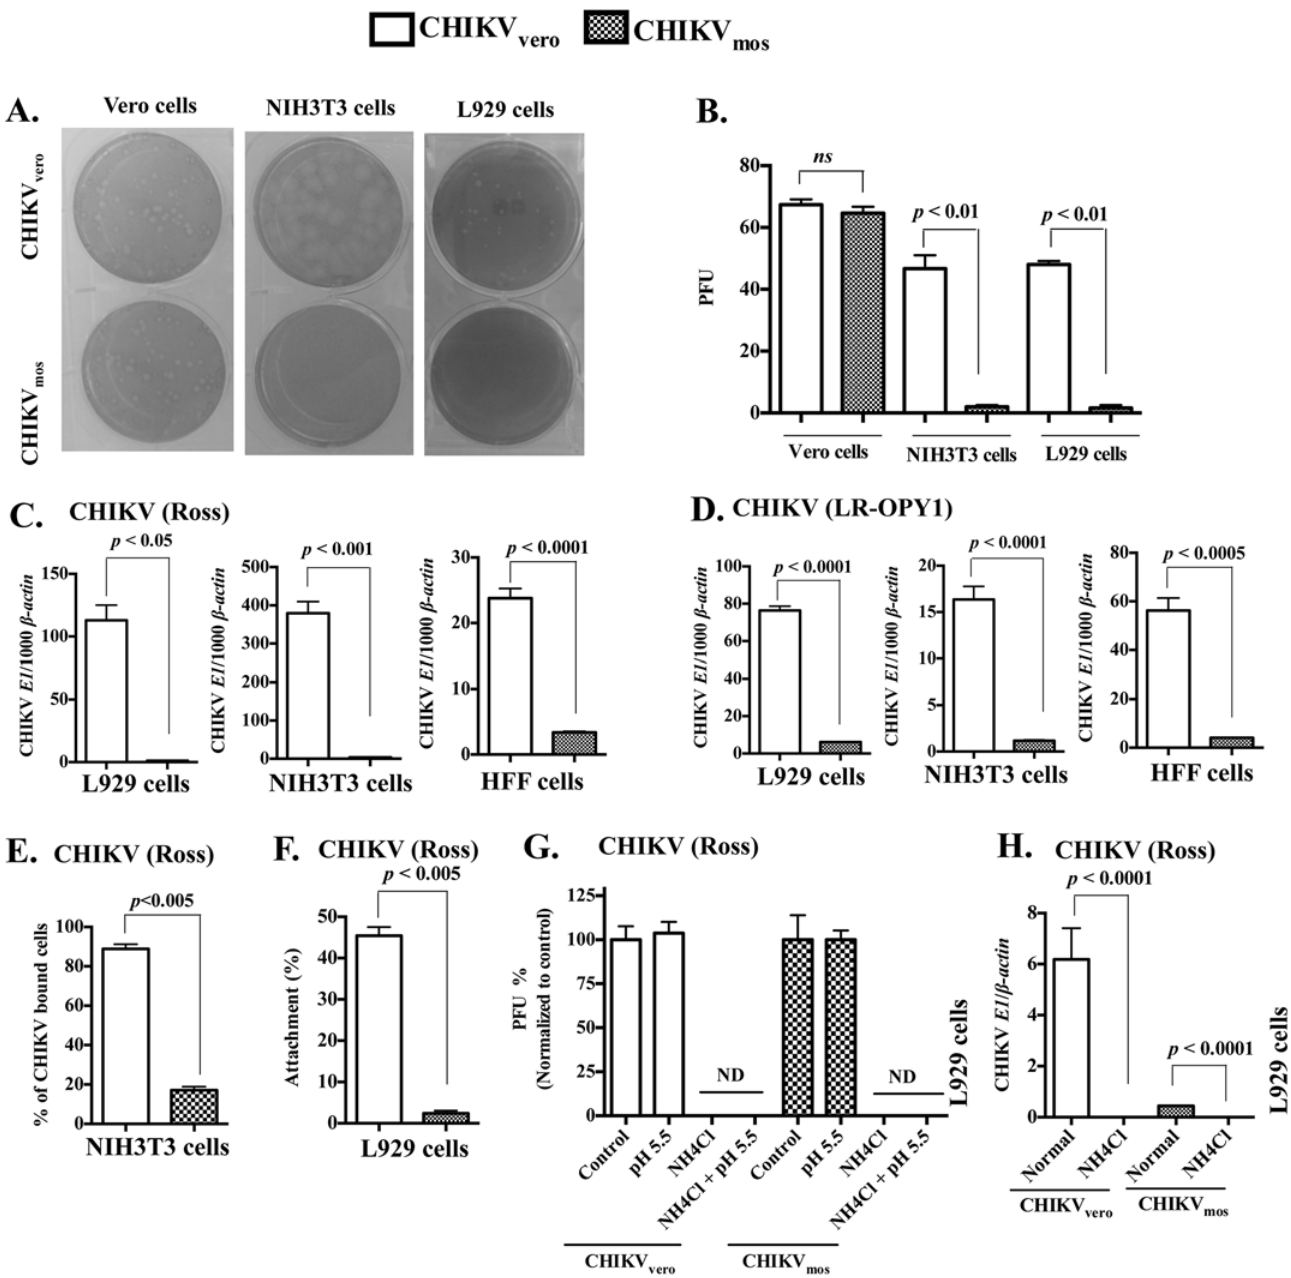
Fig 5. CHIKV mos has reduced attachment to host cells than CHIKV vero. ( A), Equal PFUs of CHIKV vero or CHIKV mos (Ross strain) were added to Vero cells (left), NIH3T3 cells (middle) and L929 cells (right) for plaque development. (B), Plaque counts of CHIKV vero and CHIKV mos in the indicated cells were quantified. (C) L929, NIH3T3 and HFF cells were inoculated with CHIKV vero or CHIKV mos (Ross strain, MOI = 1) at 4°C for 1 h and attached viruses were quantified by RT-qPCR and presented as the ratio of CHIKV E1 copy number per 1000 copy of cellular β -actin . (D) L929, NIH3T3 and HFF cells were inoculated with CHIKV vero or CHIKV mos (LR OPY1, MOI = 1) at 4°C for 1 h and viruses attached to cells were quantified by RT-qPCR. (E) NIH3T3 cells were infected with CHIKV vero or CHIKV mos (Ross strain, MOI = 2.5) at 4°C for 45 min and the virus-bound cells were quantified by flow cytometry. (F) CHIKV vero or CHIKV mos (100 PFUs) were added to monolayer of L929 cells at 4°C for 1 h and both attached and unattached viruses were quantified by plaque assay to calculate percentage attachment. (G) CHIKV vero or CHIKV mos (Ross strain, 100 PFUs) were added to the L929 cell monolayer at 4°C for 1 h. After removing unattached virus, cells were replaced with fresh medium (control), or treated with acidic medium (pH 5.5) for 2 minutes before adding fresh medium, or replaced with NH 4 Cl (20 mM) containing media. Viruses that entered into cells were analyzed by allowing plaque development for 48 h and normalized to controls. (H) Viral RNA copies in L929 cells infected with CHIKV vero or CHIKV mos (Ross strain, MOI = 1) with or without NH 4 Cl (20 mM) were measured by RT-qPCR at 24 h.p.i. Data represent at least two independent experiments performed in triplicates with the similar results. ND denotes not detected, and ns denotes not significant ( p (cid:1)